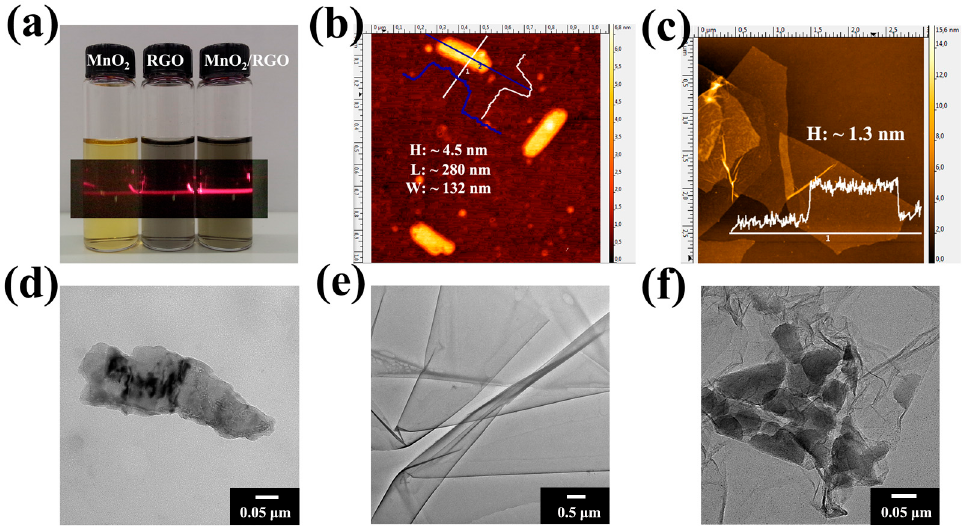
Figure 1. ( a ) Photograph of the aqueous colloidal suspensions of MnO 2 , reduced graphene oxide (RGO), and MnO 2 /RGO, showing the Tyndall effect when the red laser goes through; AFM images of ( b ) MnO 2 and ( c ) RGO; TEM images of ( d ) MnO 2 , ( e ) RGO and ( f ) MnO 2 /RGO.